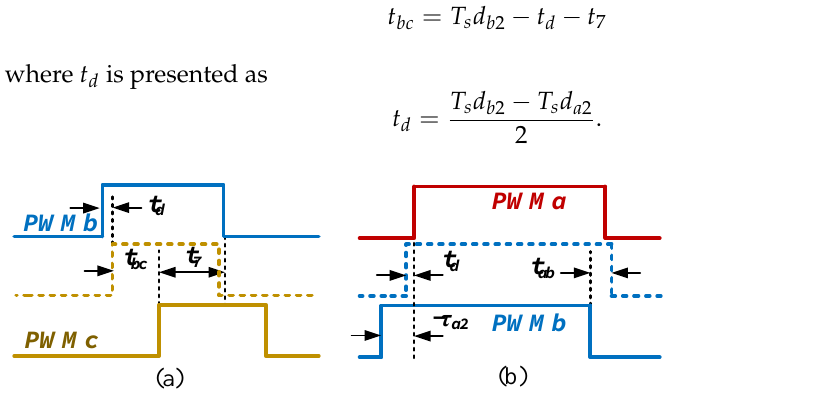
Figure 8. The relationship of the phase differences. ( a ) τ a 2 > 0, τ b 2 < 0, and τ c 2 ≤ 0, ( b ) τ a 2 ≤ 0, τ b 2 > 0, and τ c 2 >